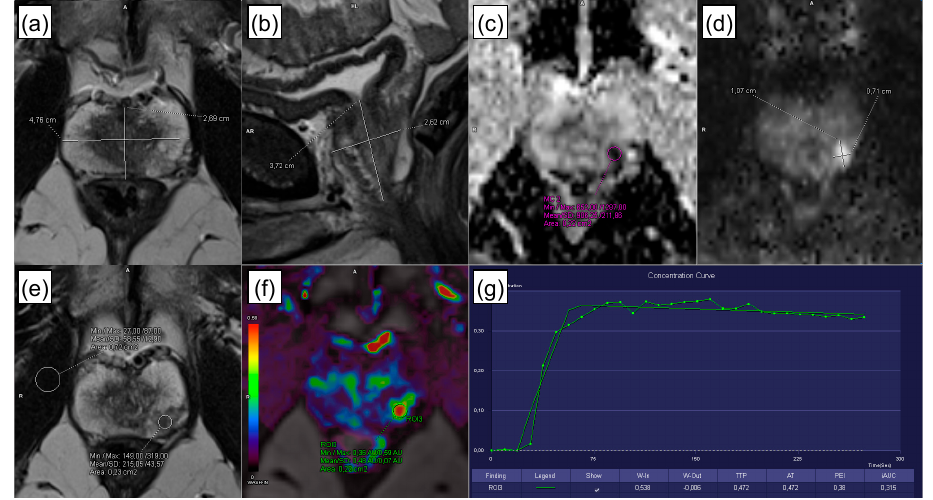
Figure 6. Image assessment. ( a , b ) Prostate volume was calculated from the diameters measured in axial and sagittal T2w images, as described in the PI-RADS v2.1 guidelines [6]. A circular region of interest (ROI) was placed within a lesion, for lesions of the peripheral zone, preferably on the ADC map ( c ) in additional consideration of DWI (calculated b-value of 1500 s/mm 2 ; ( d )), and for lesions of the transitional zone/central gland, preferably in the axial T2w sequence ( e ) [5,6]. Following placement, the ROI was copied to the other sequences using the software. If lesion measurement was difficult or compromised on ADC (for peripheral zone lesions) or T2w (for transitional zone/central gland lesions), measurements were performed on the sequence that showed the lesion best [5,6], e.g., in the above example, lesion dimensions were assessed on DWI (d). ( f , g ) Time-intensity curves were automatically calculated by the software, yielding the dynamic parameters: wash in, wash out, time to peak (TTP), peak enhancement intensity (PEI), arrival time (AT), and initial area under the curve (iAUC). DCE-MRI is an established mpMRI component. PI-RADS v2 and v2.1, however, restricted